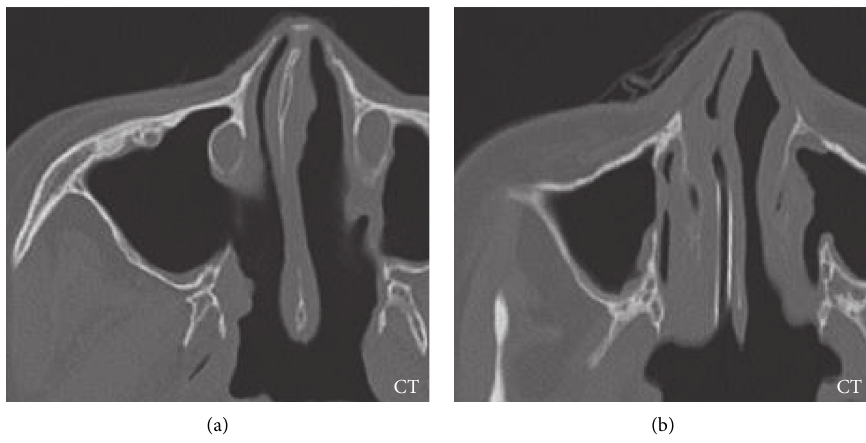
Figure 3: Post-ESS images. CT: Resected tumor in the right maxillary sinus.